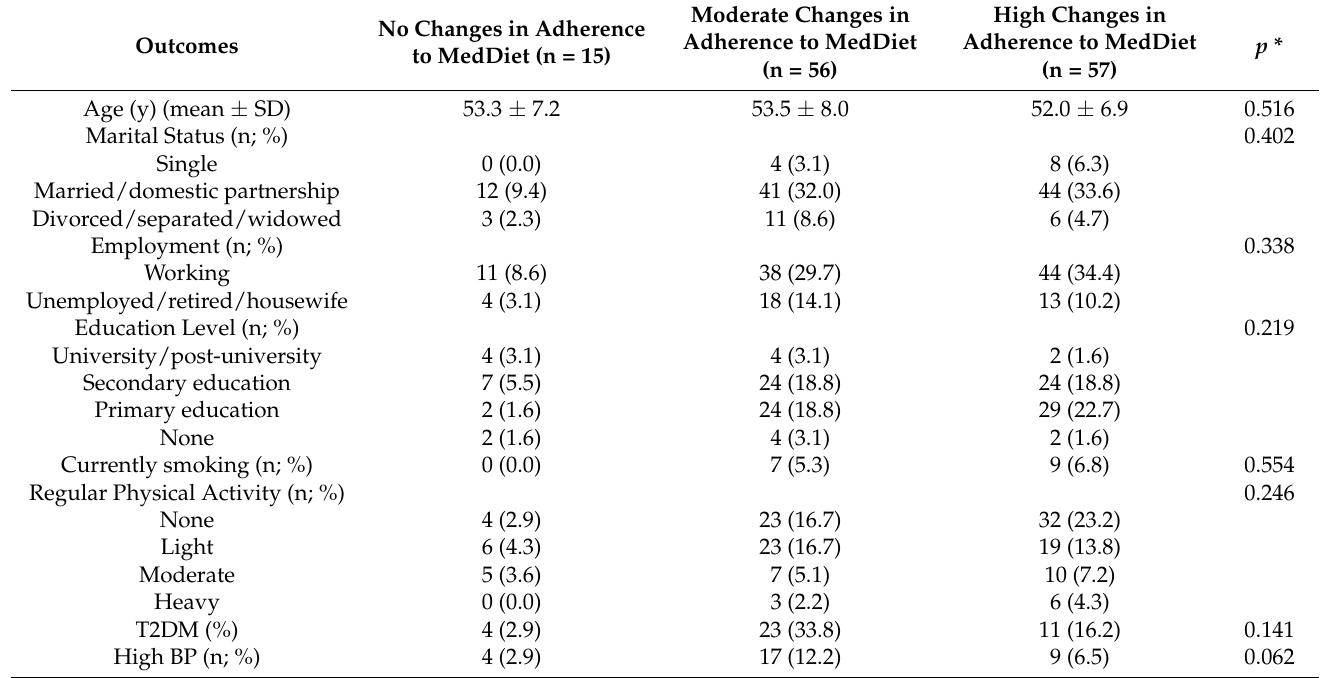
Table 1. Baseline sociodemographic characteristics according to tertiles of MedDiet adherence changes after 6-month follow-up.